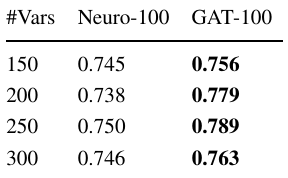
Bold values indicate the